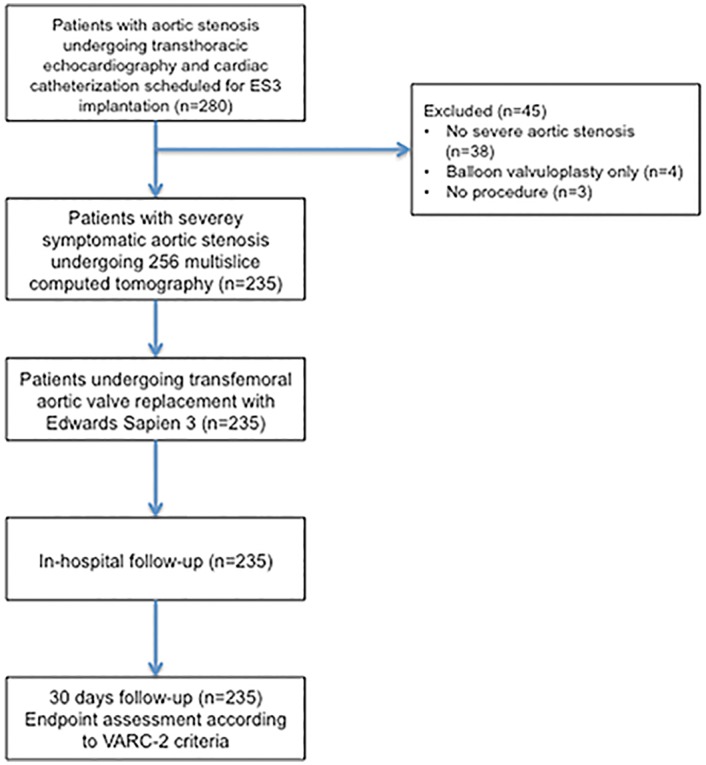
CONSORT flowchart.